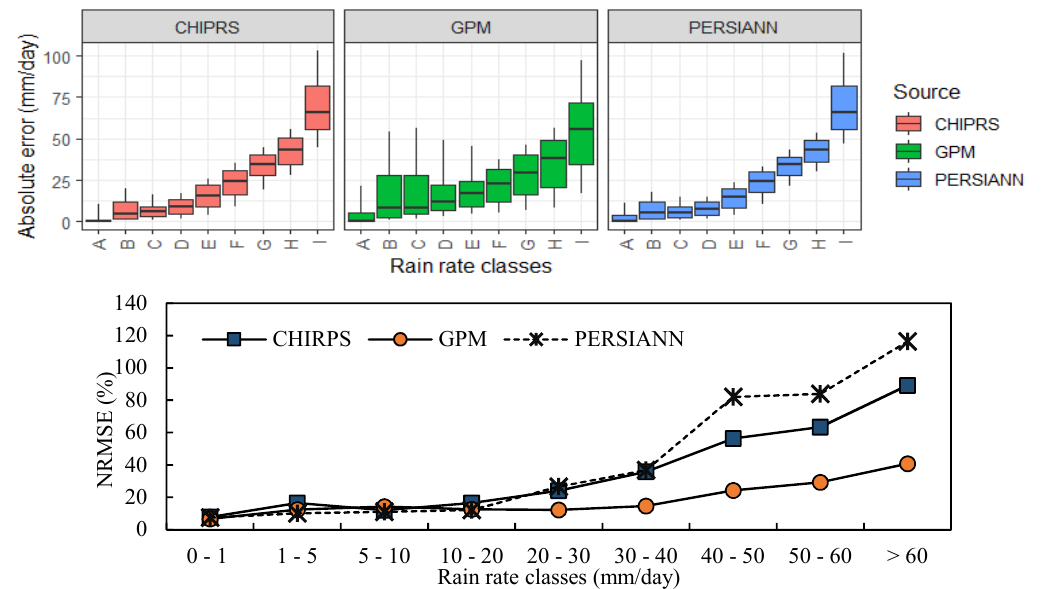
Figure 8. Errors (RMSE and NRMSE) distributions by rain rate classes: A (0–1), B (1–5), C (5–10), D (10–20), E (20–30), F (30–40), G (40–50), H (50–60), I (>60) mm/day.